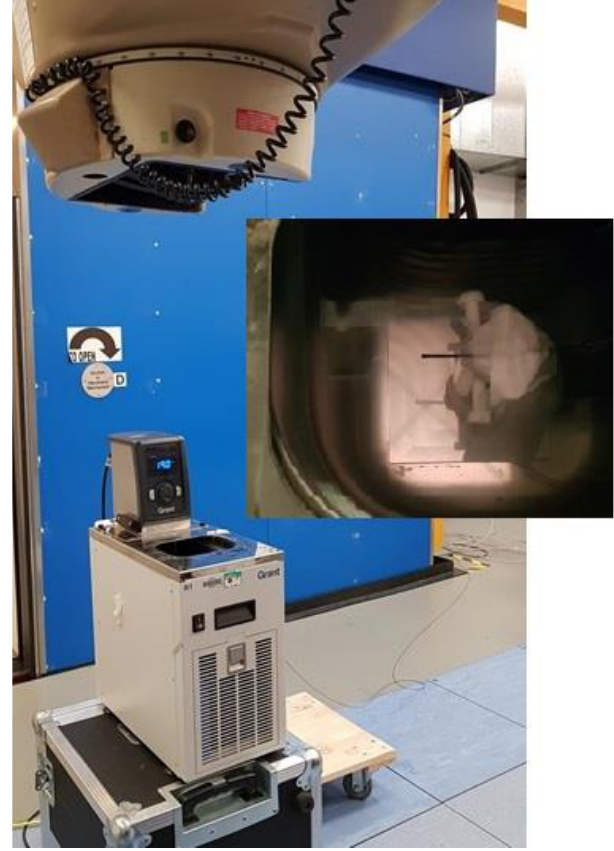
Figure 2. Theratron 780 facility and R1 Grant water bath. A zoomed photograph of the scintillator positioned inside the water bath at the centre of the radiation field. Table 1. NPL therapy level (medium-energy X-rays) reference